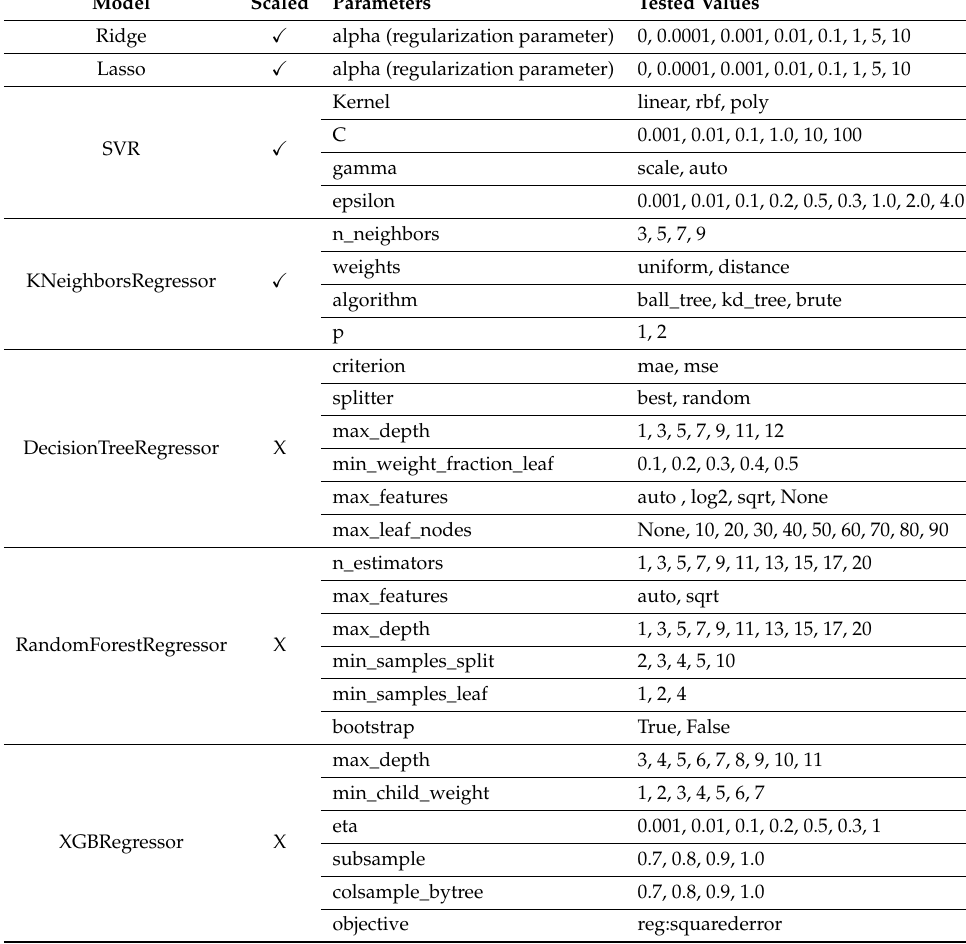
Table 2. ML models and hyperparameters (regression problem). Except for XGBRegressor, Scikit- learn was used to implement all models (https://scikit-learn.org/stable/ accessed on 15 September 2022). Python’s xgboost library was used to implement XGBRegressor. (https://xgboost.readthedocs. io/en/stable/parameter.html accessed on 15 September